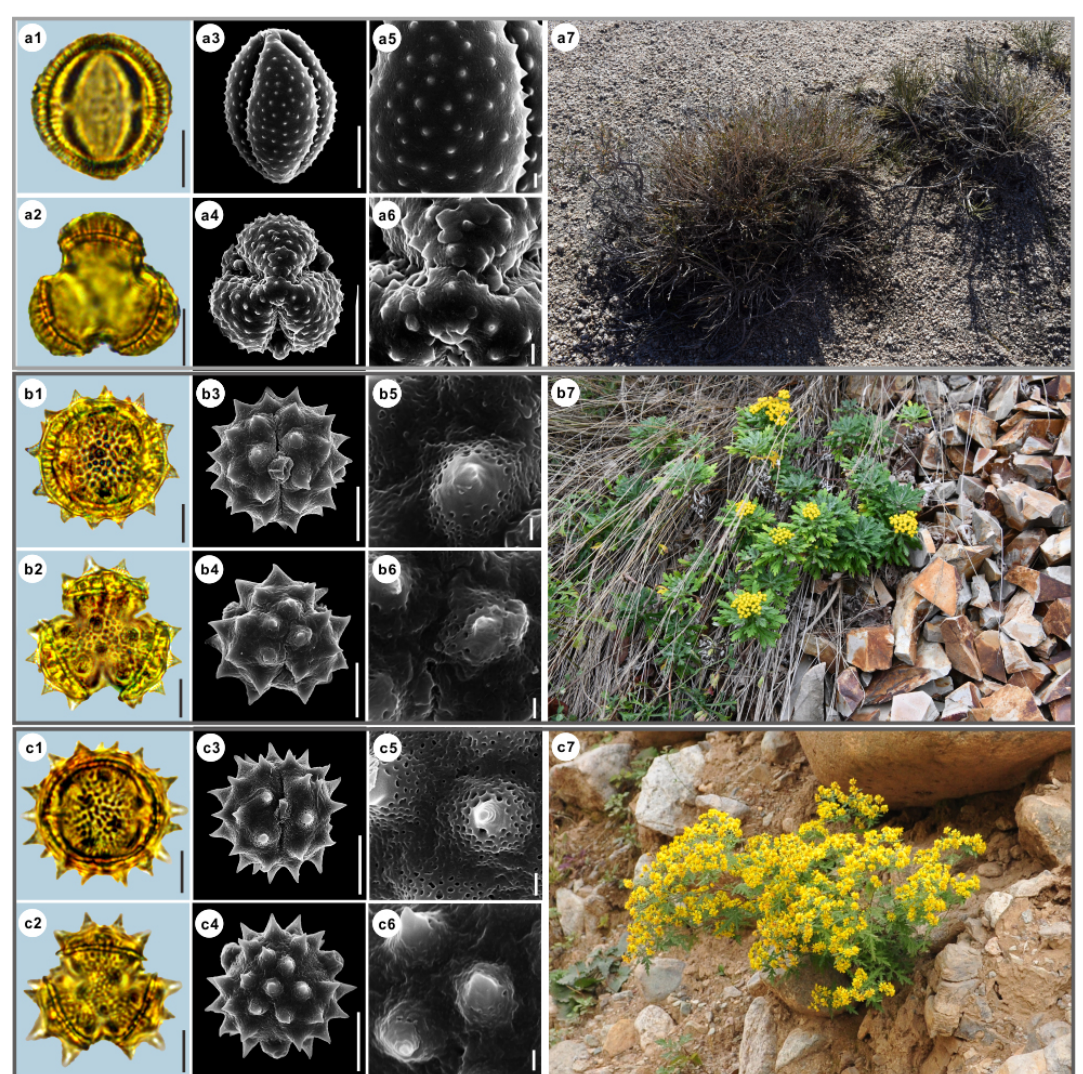
Figure 14. Pollen grains and the habitats of their source plants. (a) Kaschgaria brachanthemoides ; (b) Ajania pallasiana ; and (c) Chrysan- themum indicum . Pollen grains in equatorial view under LM (a1, b1, c1) and SEM (a3, a5, b3, b5, c3, c5) , in polar view under LM (a2, b2, c2) and SEM (a4, a6, b4, b6, c4, c6) , along with the habitats of their source plants (a7 provided by © Chen Chen, b7 cited from https://www.inaturalist.org/photos/162408714, last access: 19 August 2022, by © , c7 provided by © Bo-Han Jiao ) .